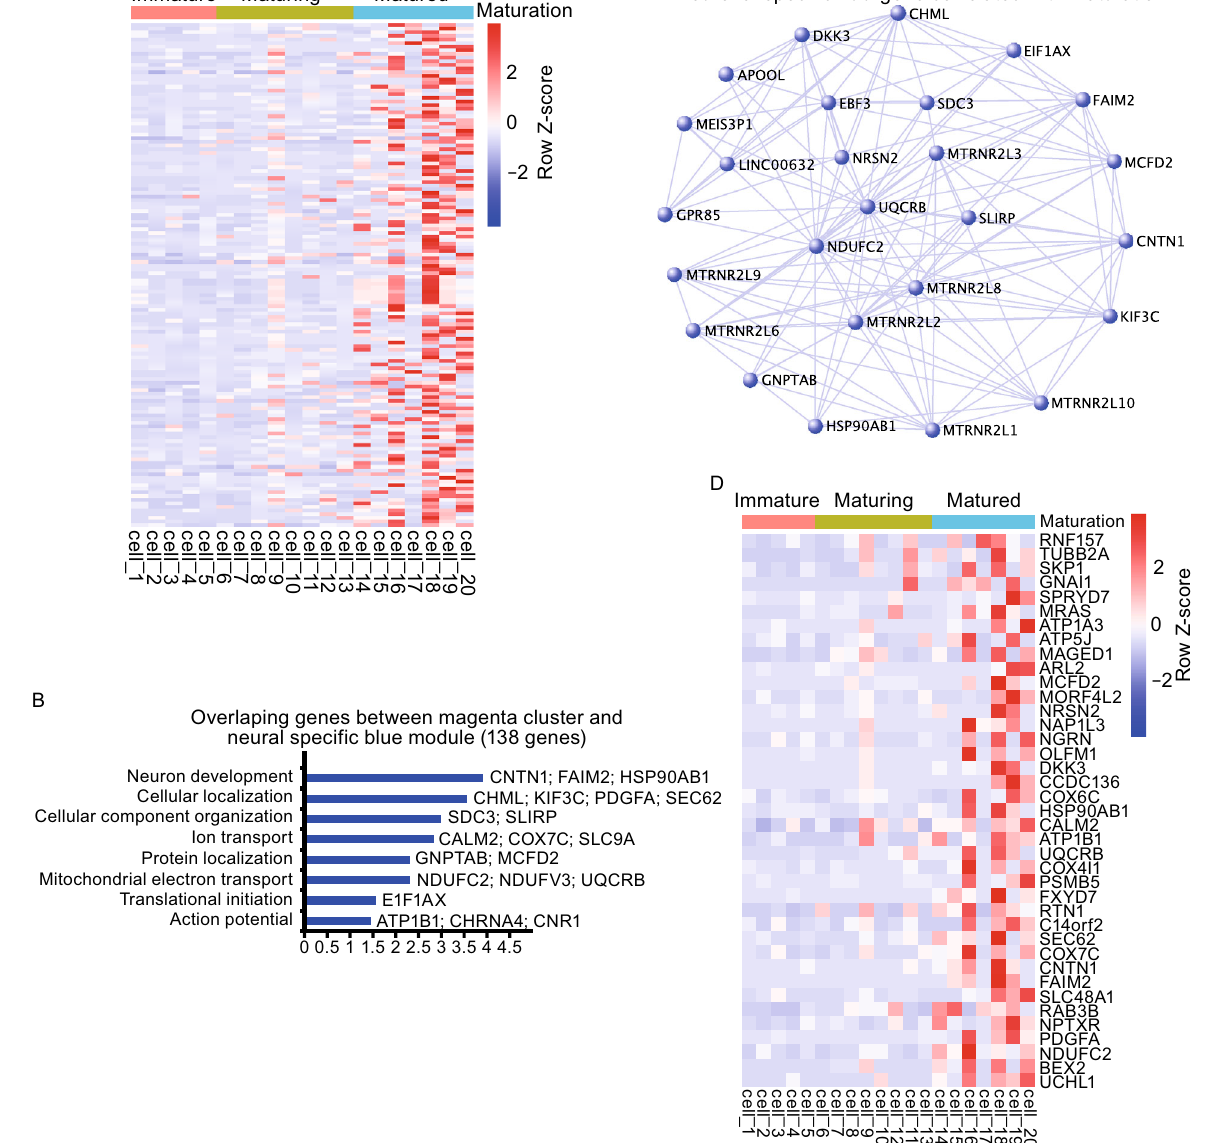
Figure 5. Identi fi cation of putative generic neuronal maturation biomarkers. (A) Expression of 138 genes in 20 single cells, which are shared between the magenta cluster and the blue module. (B) GO analyses of 138 genes. Length of bars indicated the signi fi cance ( − log10 transferred P -value, Fisher exact test). (C) Hub-gene network of the 138 genes. (D) 39 putative generic neuronal maturation genes that were also reported in Darmanis et